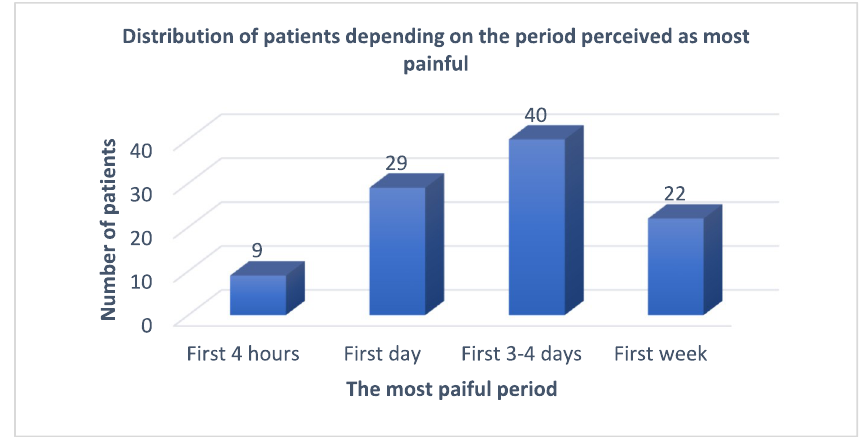
Figure 3. Distribution of patients depending on the period perceived as most painful.